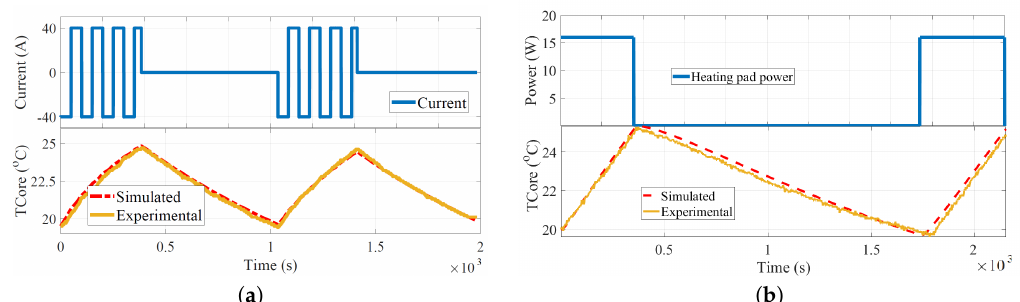
Figure 5. ( a ) internal bi-directional current preheat and ( b ) externally heating profiles and models validations.